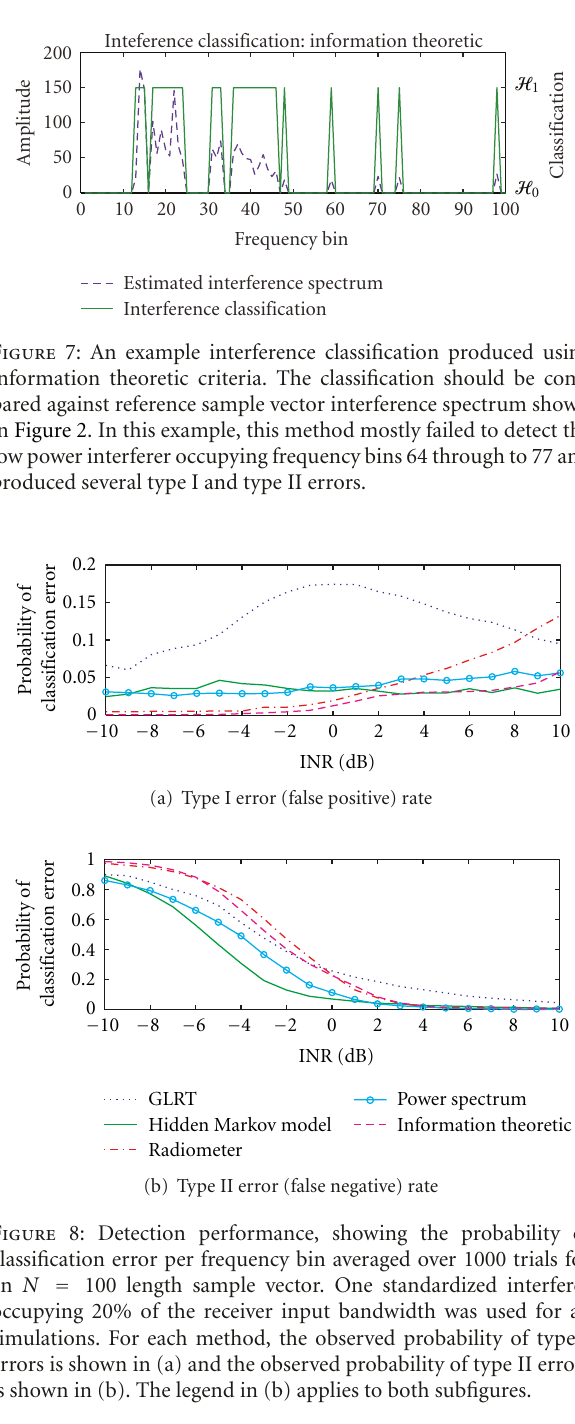
(cid:18) N p H | X n , H the lowest n = 1 TypeII ( 0 1 ) were HMM and power spectrum analysis with HMM performing best at low INR. Note that the two methods which produced the least type I also produced the most type II errors at low INR. HMM probability of classification error, with HMM being the best performed